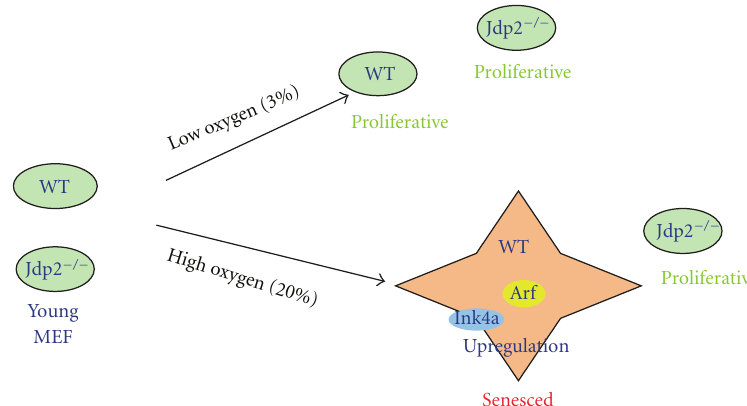
Figure 2: Oxydative stress controls the cell proliferation of mouse MEF cells through the epigenetic regulation of the p 16 Ink 4 a / Arf locus by JDP2. Young MEF primary cells exposed to oxidative stress (20%) accumulate JDP2. In the presence of JDP2, PRC1, and PRC2 dissociate from the p 16 Ink 4 a / Arf locus, and histone H3 on the promoter is demethylated. Finally, p16 Ink4a and Arf are upregulated to express and then aged cells senescence. In the absence of JDP2, MEF cells do not enter the senescence stage and proliferate well. In the lower oxygen (3%), both WT and Jdp2 − / − MEF cells are not senesced but proliferated.